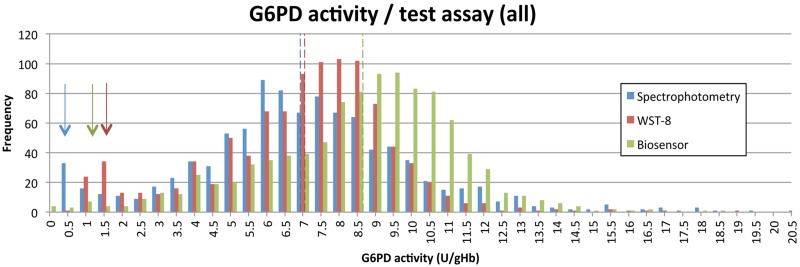
G6PD activity distribution according to different assays among the entire study population.Arrows indicate the peak for G6PDd samples / assay, dotted lines indicate AMM / assay.